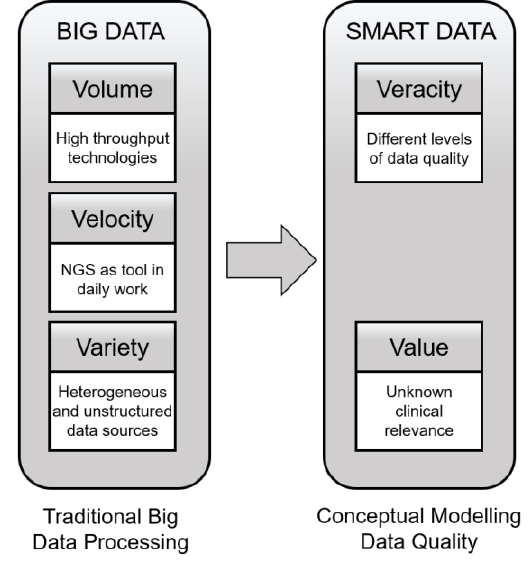
Figure 2. From Big Data to Smart Data